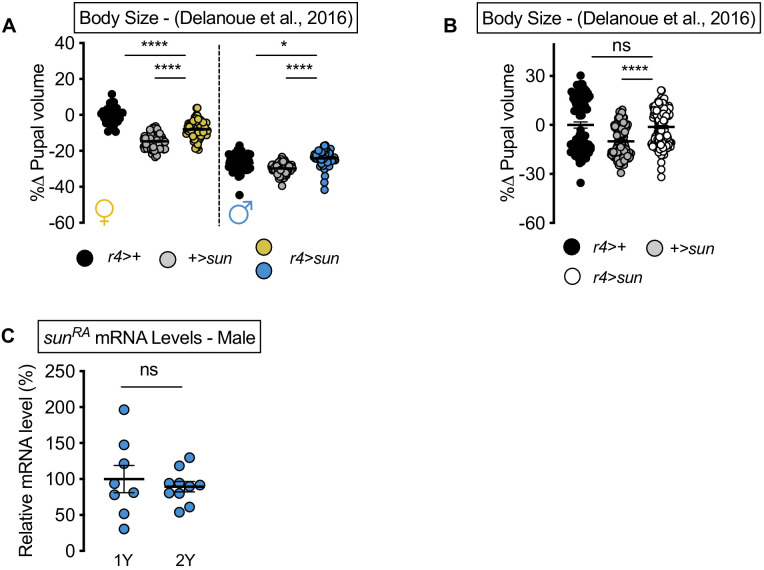
stunted (sun) overexpression augments body size in the diet used in Delanoue et al., 2016 in males.(A) Pupal volume was not significantly larger in r4>UAS-sun females compared with r4>+ and +>UAS-sun control females cultured on the diet used in Delanoue et al., 2016 (p<0.0001 for both comparisons; two-way ANOVA followed by Tukey HSD test). Pupal volume was significantly larger in r4>UAS-sun males compared with r4>+ and +>UAS-sun control males cultured on the diet used in Delanoue et al., 2016 (p=0.0104 and p<0.0001, respectively; two-way ANOVA followed by Tukey HSD test). n = 36–95 pupae. (B) Pupal volume was not significantly different in pooled in r4>UAS-sun males and females compared with pooled r4>+ and +>UAS-sun control males and females cultured on the diet used in Delanoue et al., 2016 (p=0.7224 and p<0.0001, respectively; two-way ANOVA followed by Tukey HSD test). n = 77–174 pupae. (C) mRNA levels of sunRA were not significantly different in r4>UAS-sun males cultured on 1Y compared to genotype matched males cultured on 2Y (p=0.5763; Student’s t test). n = 8–10 biological replicates. For body size graphs, filled circles indicate pupal volume and error bars indicate SEM. * indicates p<0.05, **** indicates p<0.0001; ns indicates not significant.